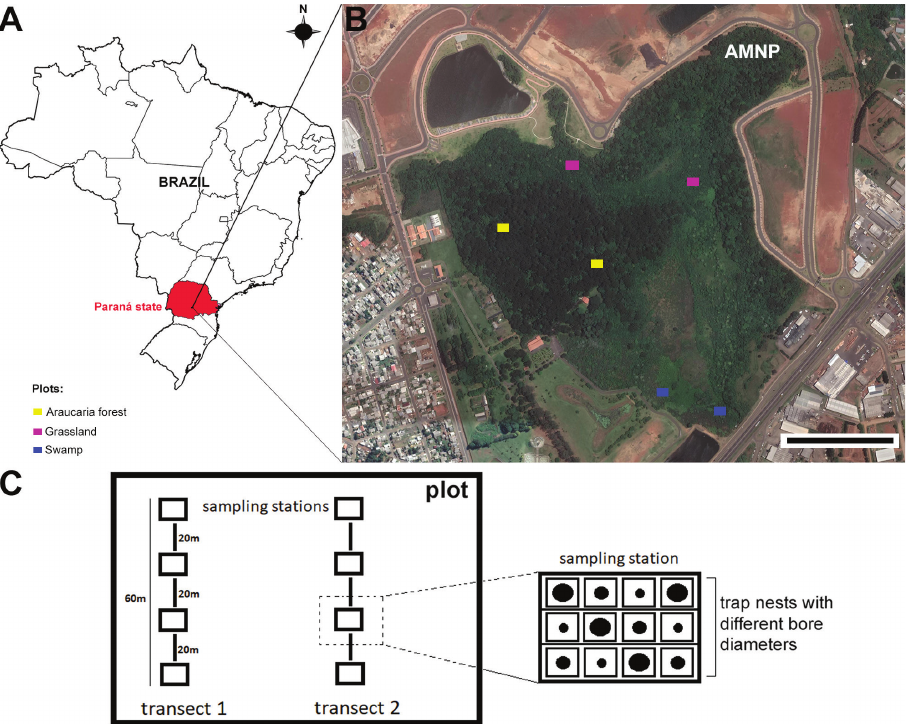
Figure 1. Study site and schematic representation of our trap-nest experiment A Map showing the exact location of AMNP within Paraná state, Brazil B Satellite image of AMNP with color-coded rectangles pointing to where the collecting plots were set up within each environment C Line art depicting that plots consisted of two 60-meter transects, each containing four sampling stations with 12 trap nests of different bore diameters. Scale bar: 250